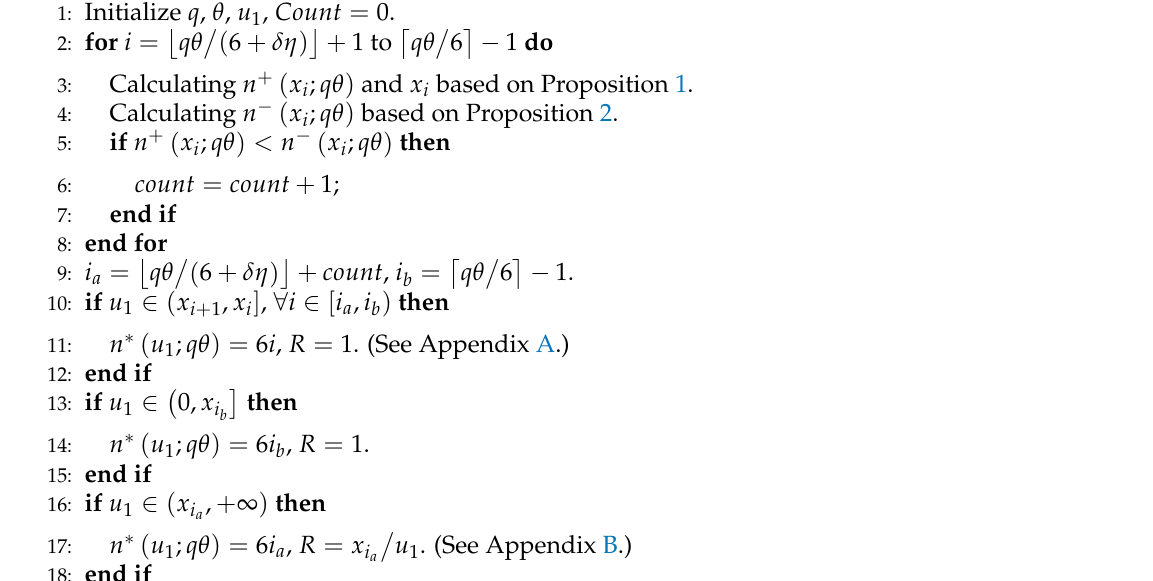
Algorithm 1 RBs Allocation for PRACH for the